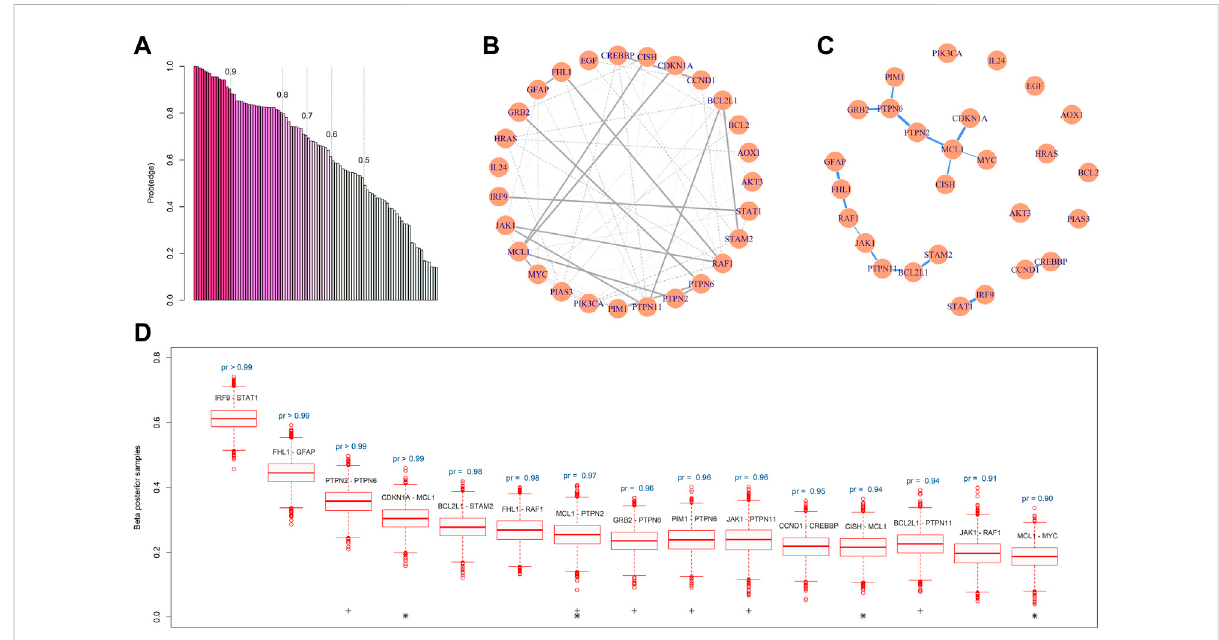
FIGURE 4 Gene regulatory network constructed by BMRF.P. (A) The ordered probabilities of the 99 edges are estimated by BMRF.P, and different colors correspondtodifferentthresholds.The fi rst69aretheedgeswithaprobabilitygreaterthan0.5; (B) Theestimatedgeneticnetwork.The15thicklines are edges with an estimated existence probability greater than 0.9; (C) The network structure containing only the 15 edges, where the width of the edge corresponds to the magnitude of the existence probability; (D) Boxplots of the posterior samples of the strength coef fi cient corresponding to each one of the 15 edges. The text above the boxplot represents the estimated existence probability. The ‘ + ’ indicates edges involving genes in the PTPN family and ‘ * ’ involves MCL1